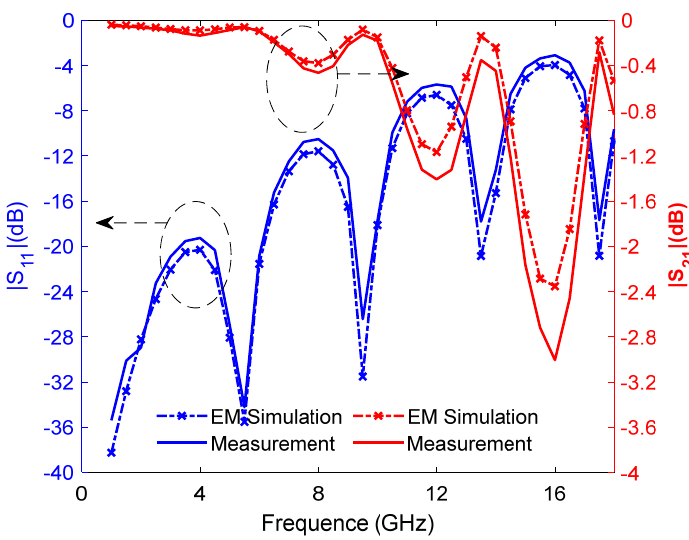
Figure 5. Photograph of the fabricated FCWI-to-FCWI.